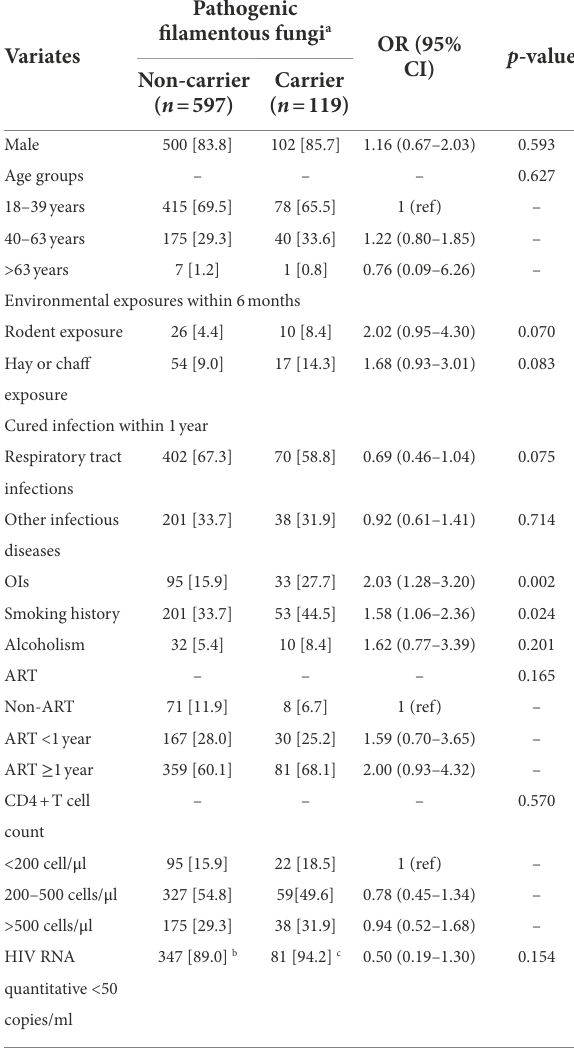
TABLE 3 Univariate analysis of risk factors for pathogenic filamentous fungi carriage in HIV-infected group.